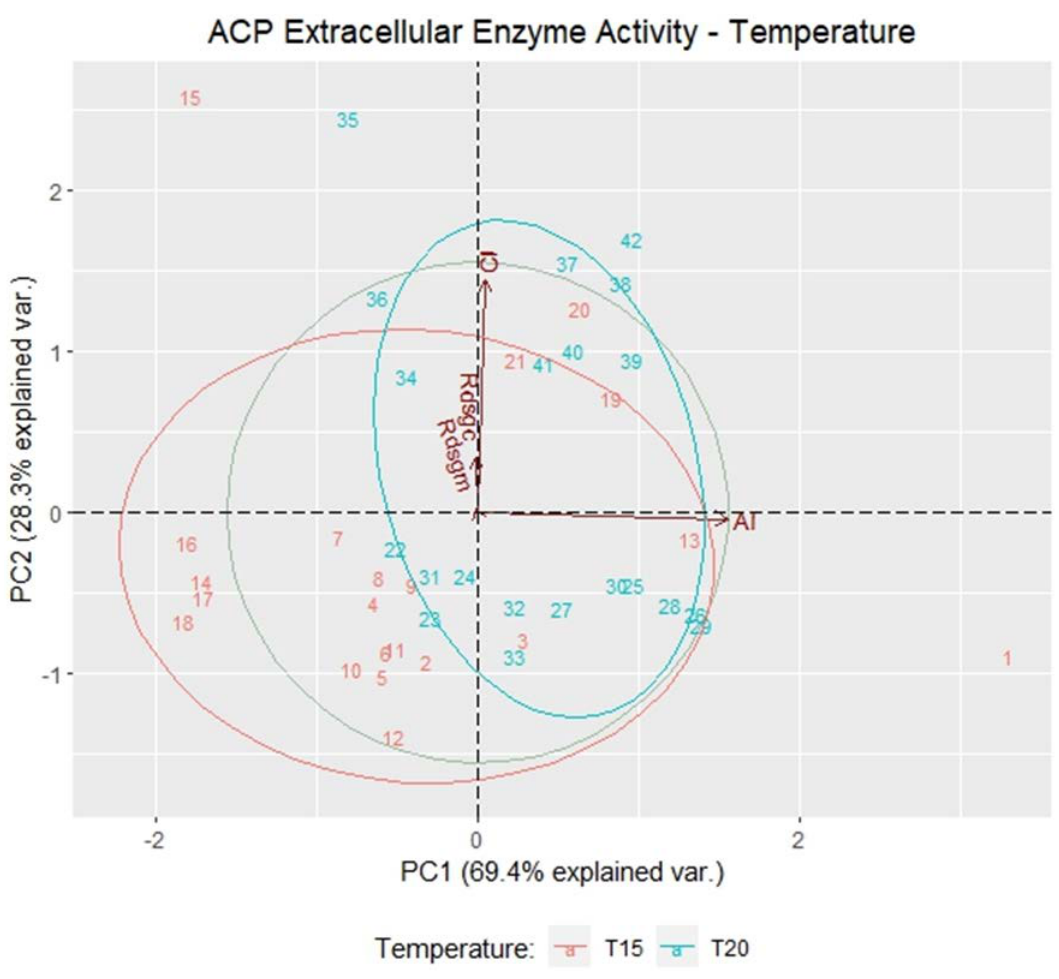
Figure 4. The main components of the extracellular enzyme activity of bacterial strains grown at 15 and 20 °C in the variables cellulolytic index (CI), amylolytic index (AI), enzyme activity in bacteria with higher cellulolytic activity (Rdsgc), and enzyme activity in bacteria with higher amylolytic ac- tivity